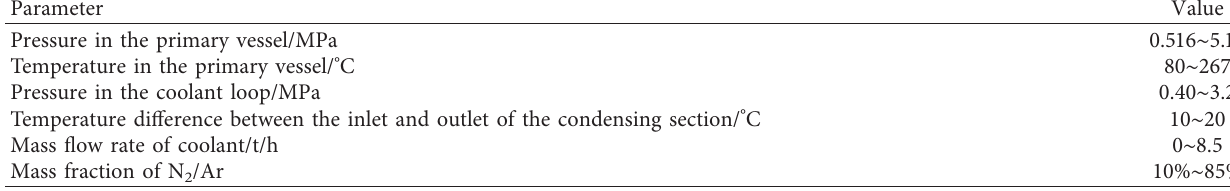
Table 1: Experimental conditions of steam condensation in the presence of nitrogen/argon.